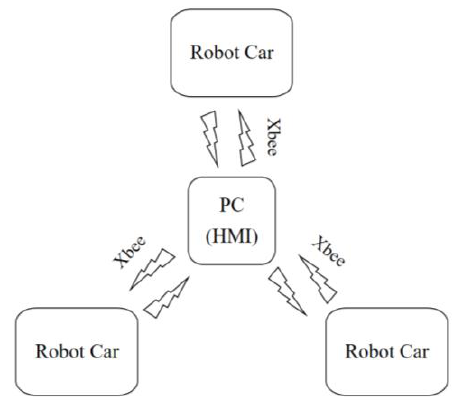
Figure 6. The Robot Cars System Architecture.